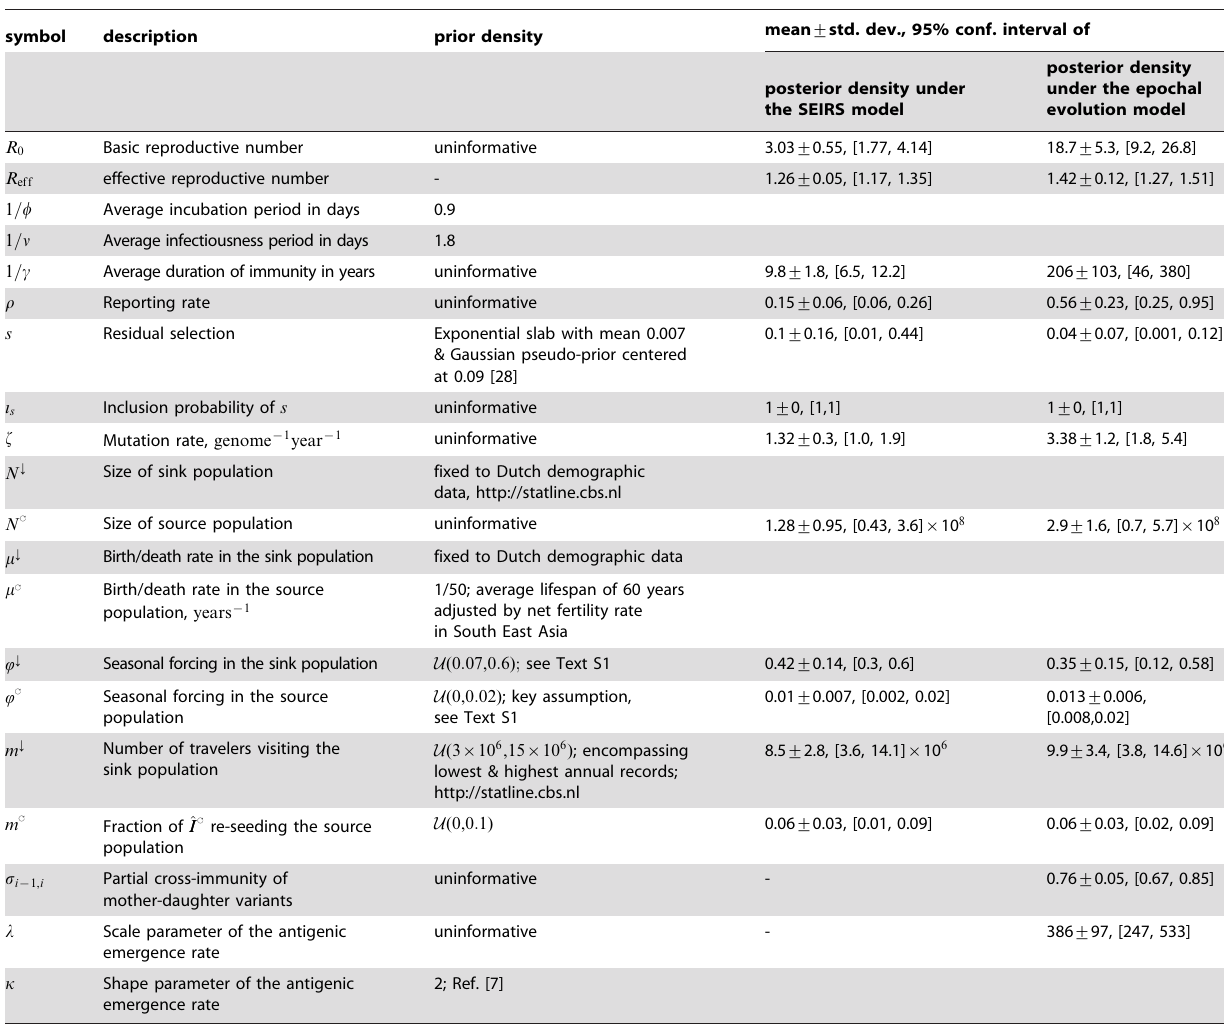
Table 2. Phylodynamic model parameters, prior and estimated densities.